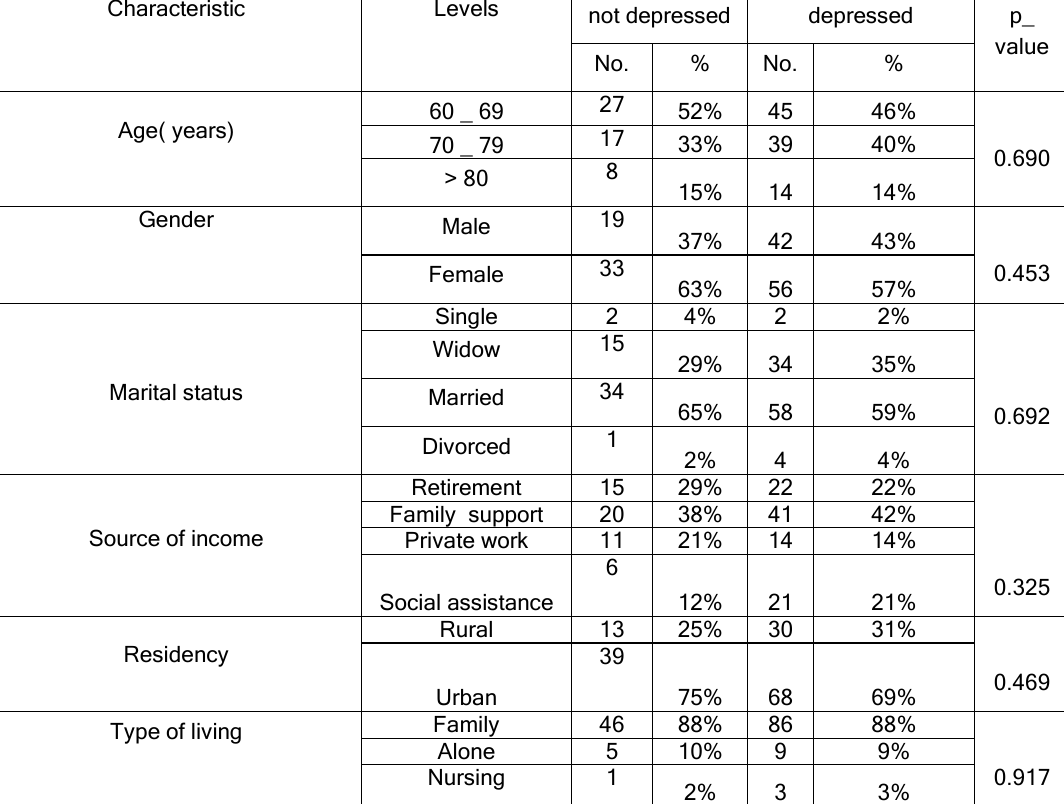
Table ( 2 ) Demographical characteristics in depressed &non depressed sample.